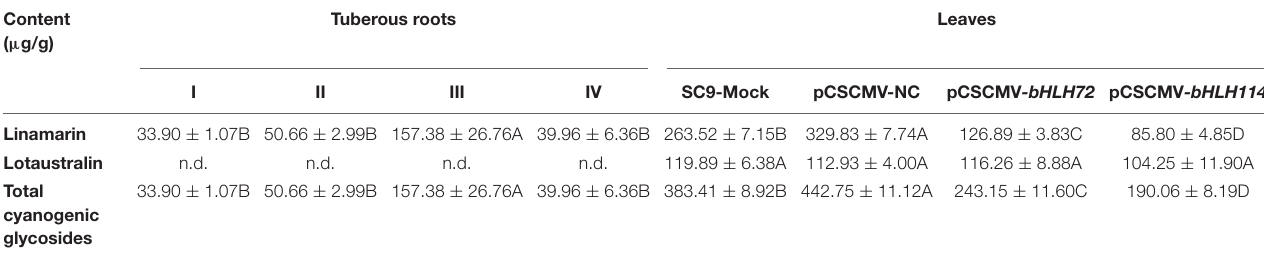
TABLE 1 | Cyanogenic glucosides content of tuberous roots in four PPD samples and cassava leaves infected with pCsCMV- bHLH72 and pCsCMV- bHLH114 . Content ( µ g/g)